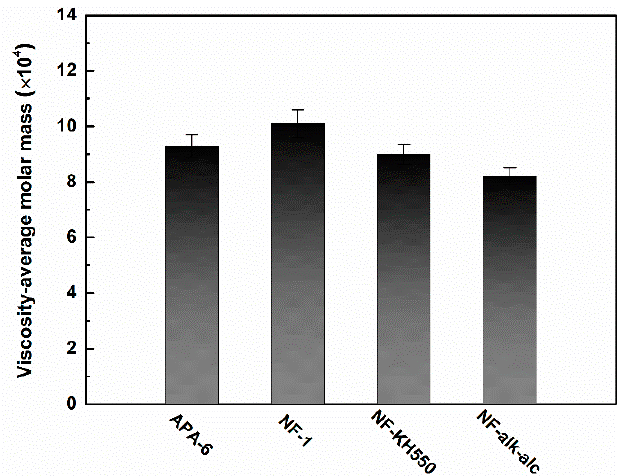
Figure 9. Viscosity-average molecular weight of di ff erent modified ramie fabrics reinforced APA-6 composites.